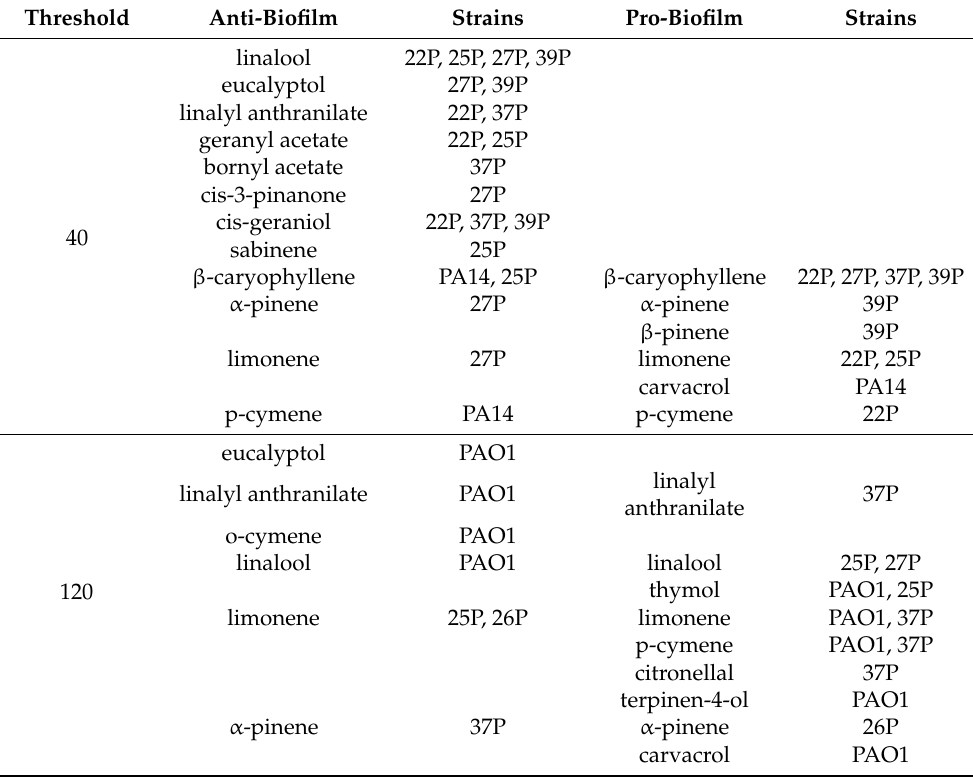
Figure 2. Weighted feature importance (WFI) plot for models F7 to F11 obtained on the dataset binarized at 120% biofilm inhibition. Positive bars are associated with inhibition of biofilm production, whereas negative bars are associated with augmented biofilm production. Only the 10 highest (anti-biofilm) and 10 lowest (pro-biofilm) values are displayed. Table 3. Summary on predicted essential oils’ (EO) single compounds influence on biofilm modulation at 40% and 120% threshold values. Compounds with an absolute value of FWI higher than 3 are